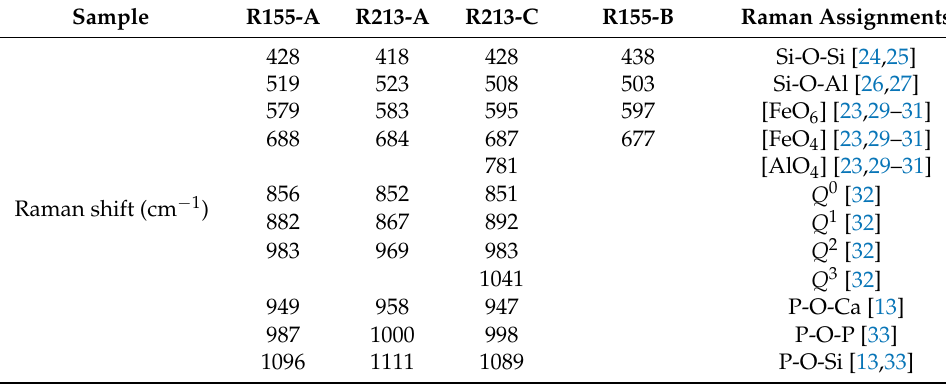
Table 5. Structure units corresponding to the fitting peaks in Raman